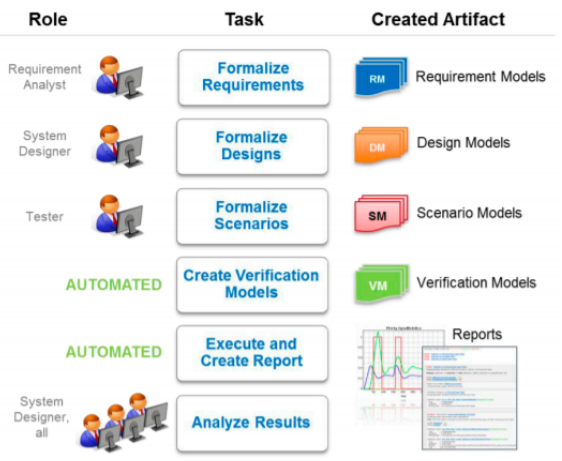
Figure 1. vVDR flow of information—steps, roles, tasks, and artifacts